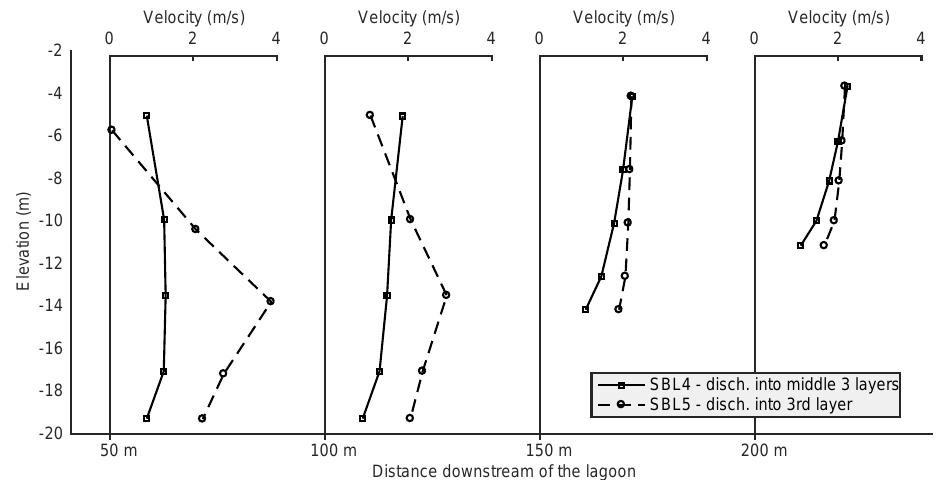
Figure 14. Representative 3D velocity profiles for SBL4 and SBL5 during the ebb generation in four locations downstream of the turbine during generation phase.